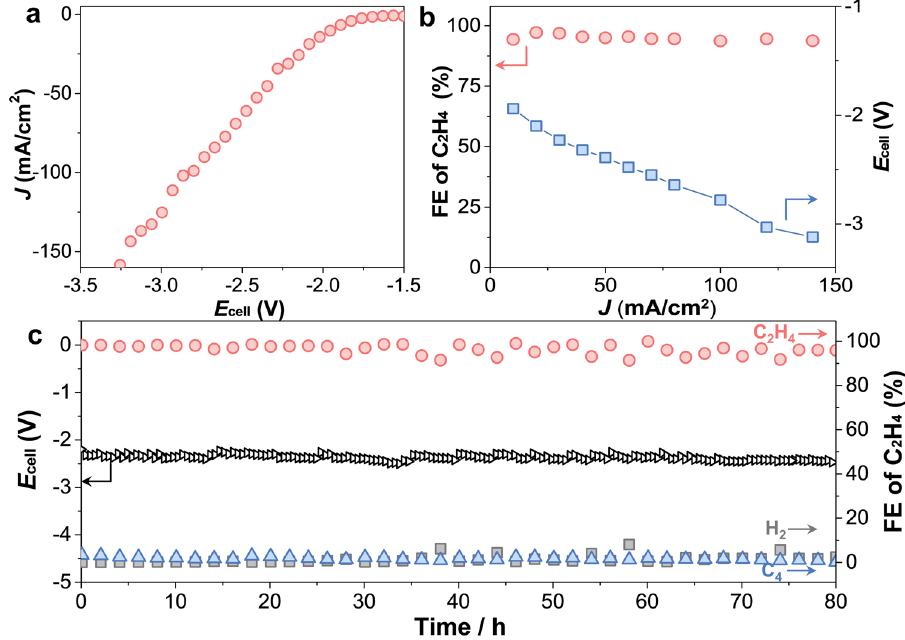
Fig. 3 The EAH performance of NHC – Cu in a two-electrode fl ow cell. a LSV curve of NHC – Cu in a 1 M KOH aqueous solution fed with pure acetylene. b Ethylene FEs and corresponding E cell as a function of current densities. c Long − term EAH durability test of NHC – Cu at 30 mA/cm 2 .